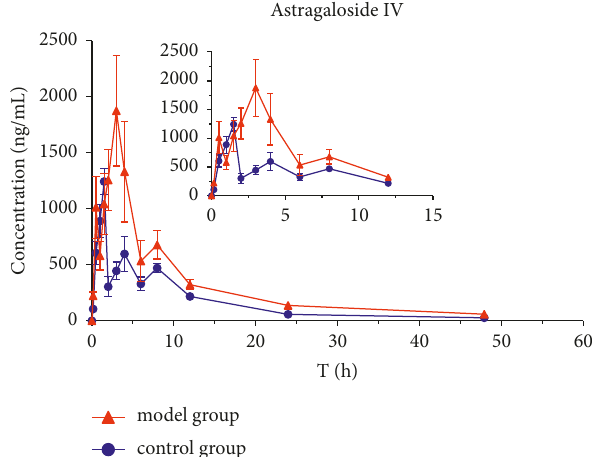
Figure 5: Concentration-time profiles of astragaloside IV after HQD administration ( x ± SD, n � 8).